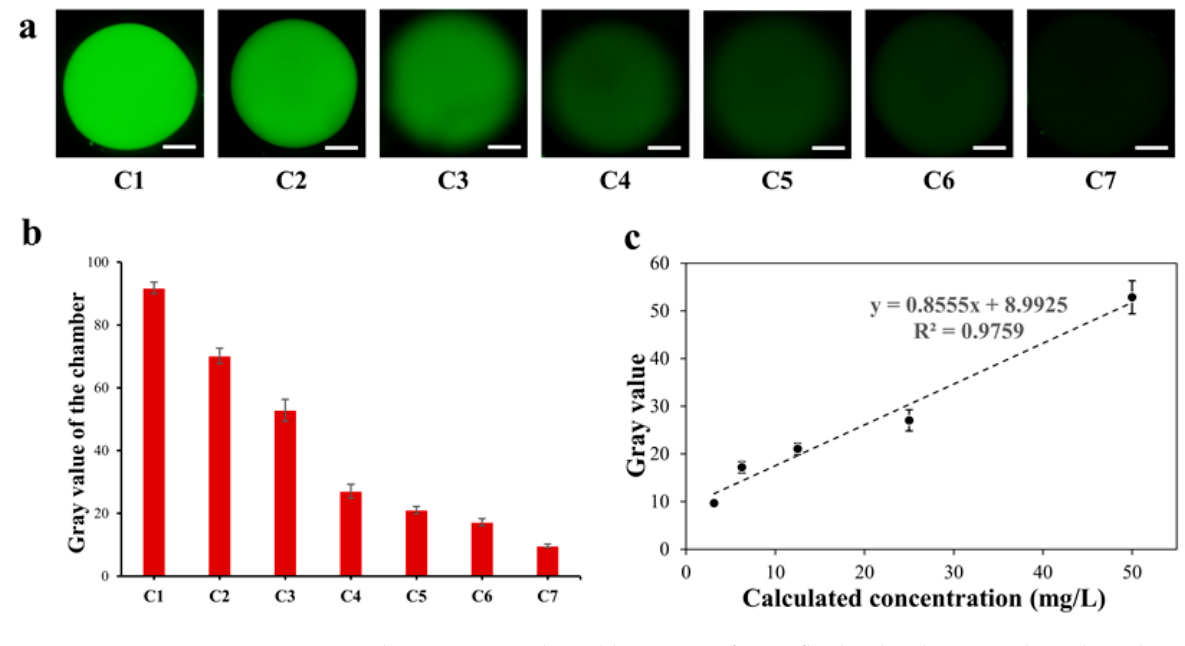
Figure 4. Fluorescence gradient dilution test of microfluidic SlipChip. Error bars show the standard deviations of measurements from at least three separate experiments. ( a ) Fluorescent pictures of rhodamine fluorescent dye in seven microchambers of SlipChip. White scale bar: 500 μ m; ( b ) The gray value of the fluorescent pictures in the microchamber of the SlipChip; ( c ) Linear relation diagram of fluorescent dye concentration (3.125 mg/L to 50 mg/L) and gray value. This followed the linear equation: y = 0.8555x + 8.9925, with a correlation of R 2 = 0.9759.